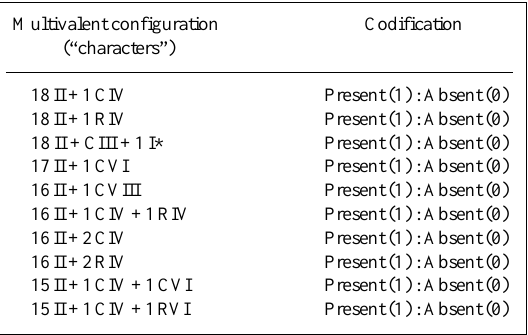
Table II - Codification of the multivalent configurations employed as “characters”. Multivalent configuration Codification (“characters”)